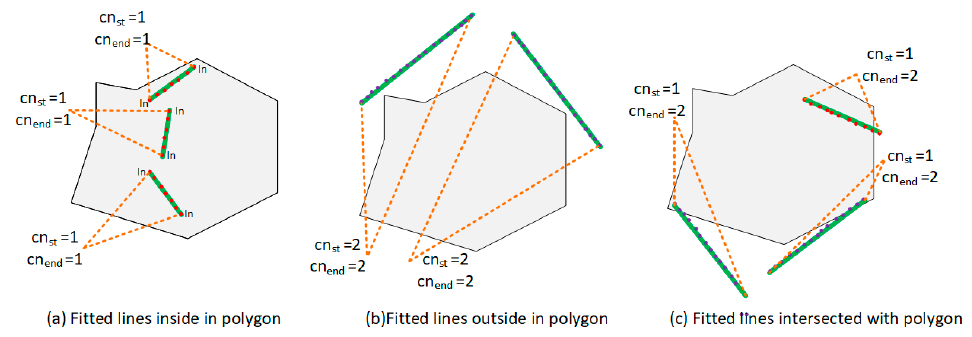
Figure 6. Crossing number method for wall planes extraction.